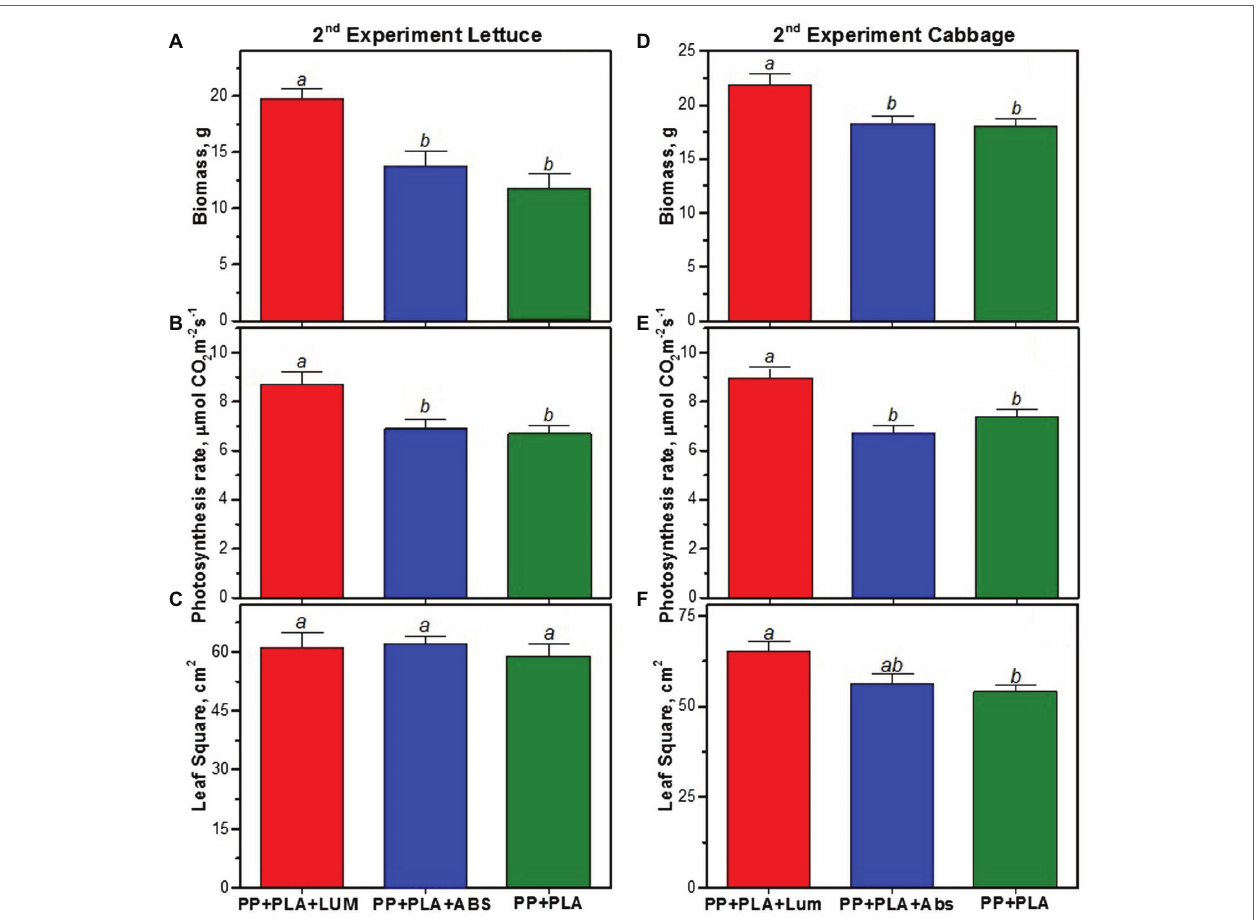
FIGURE 6 | Experiment 2. Biomass accumulation (A,D) , photosynthesis rate (B,E) , and average leaf area (C,F) of lettuce and cabbage, respectively, grown for 32 days under agrotextiles: PP + PLA + LUM, PP + PLA + ABS, and PP + PLA. Mean values ± SE are given. The values indicated in a row by different letters (a or b) significantly differ from each other ( p <